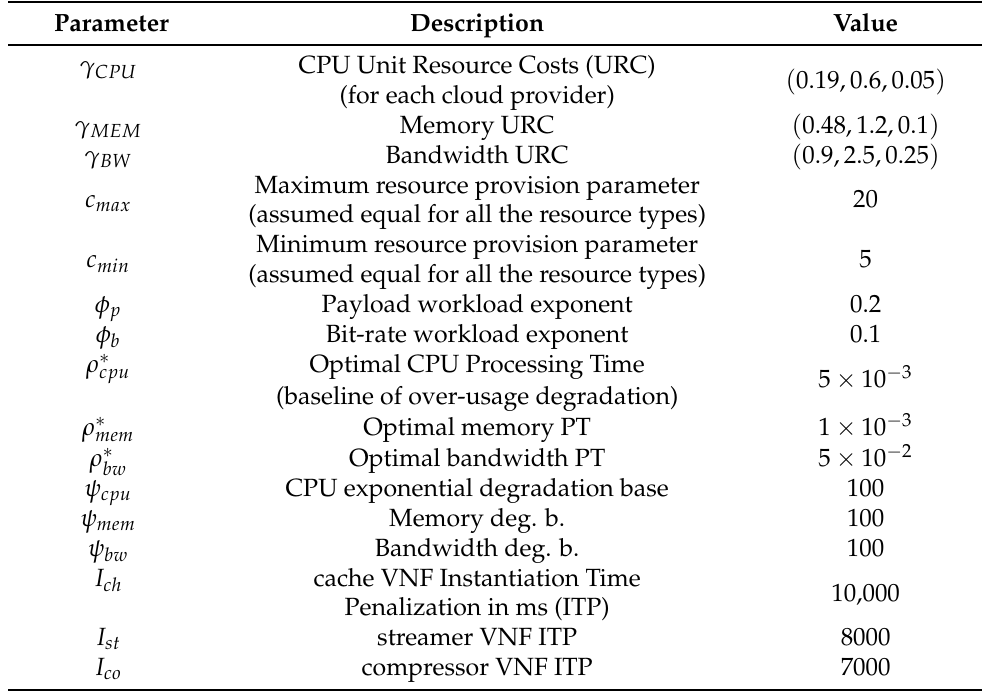
Table A1. List of simulation